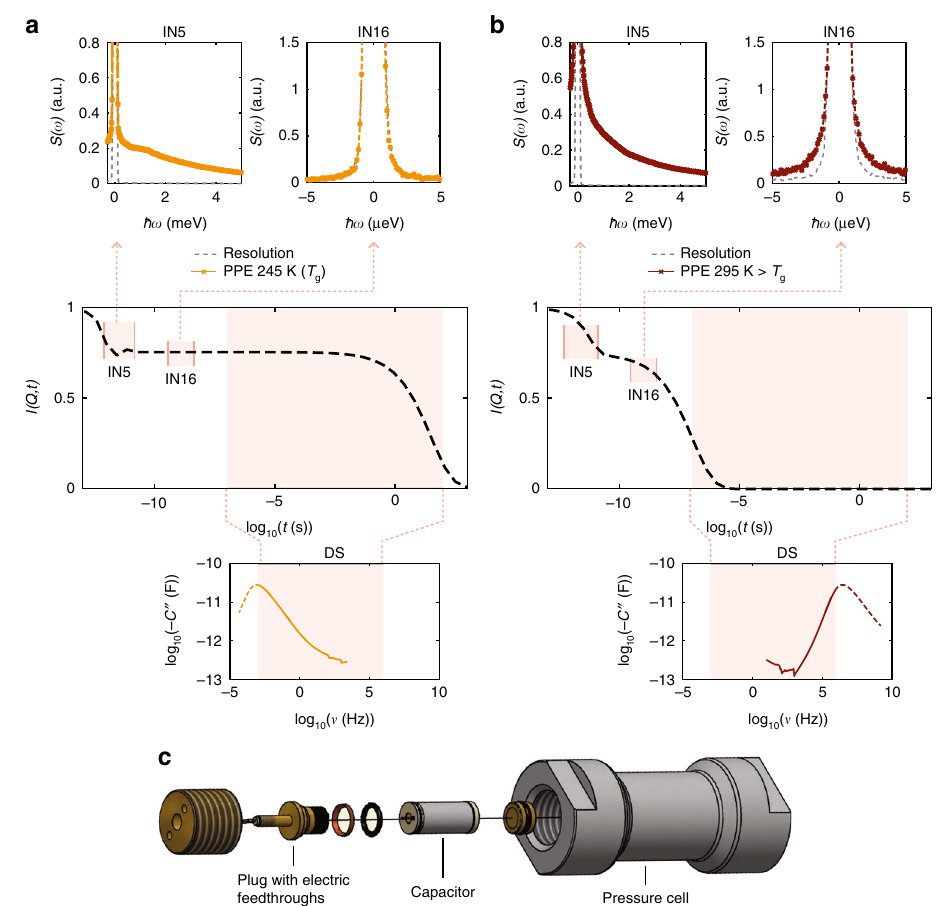
Fig. 1 Dynamics probed with dielectric (DS) and neutron spectroscopy. a , b Sketch the incoherent intermediate scattering function I ( Q , t ) in the center panel. Top panels show raw spectra measured on the time-of- fl ight and backscattering spectrometers IN5 and IN16, respectively, and bottom panels show spectra from DS, all measured on PPE. Dashed lines in DS are from time-temperature superpositon (TTS). a Dynamics at the glass transition T g where there is separation of timescales. At picosecond timescales we observe fast relaxation and vibrations. At nanosecond timescales there is no relaxation and the alpha relaxation is only visible in DS. b Dynamics in the liquid well above T g . Relaxation dominates the signal in all three spectrometers. c Drawing of components of simultaneous high-pressure dielectric and neutron spectroscopy